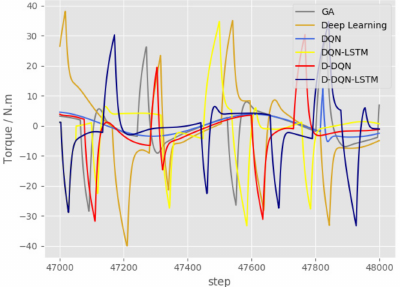
Figure 23. Torque curve between 47,000 and 48,000 in a complicated